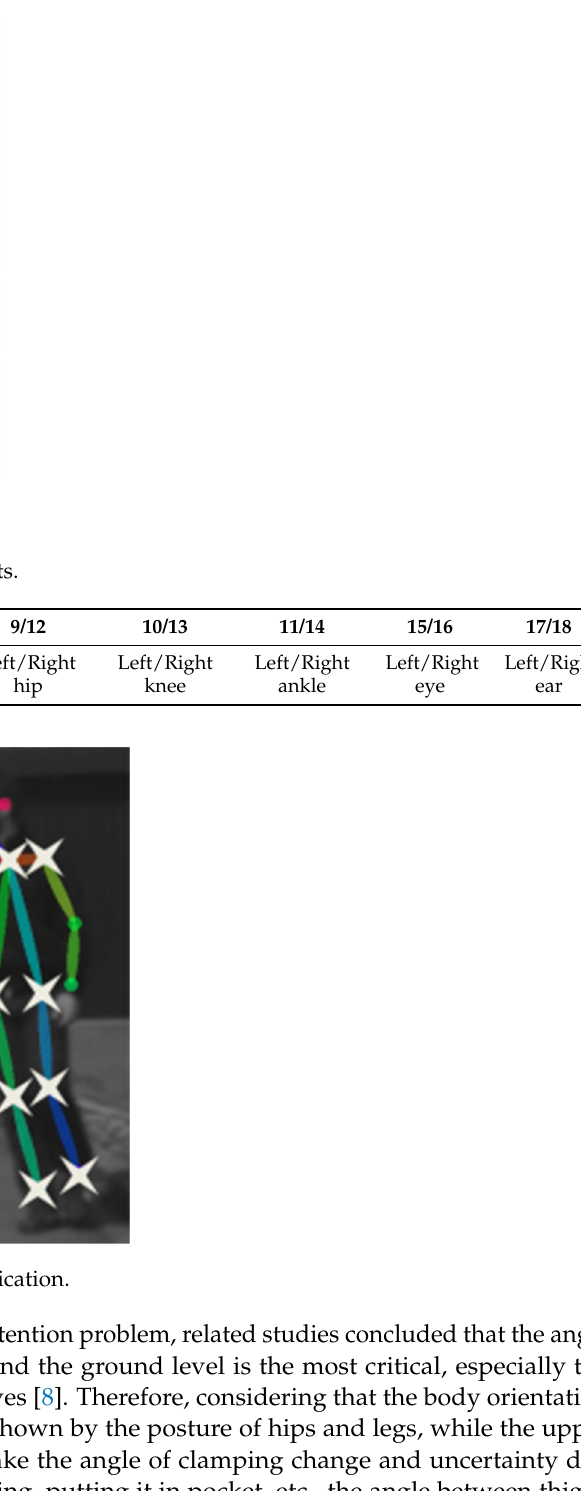
Figure 3. Key points for stable identification.